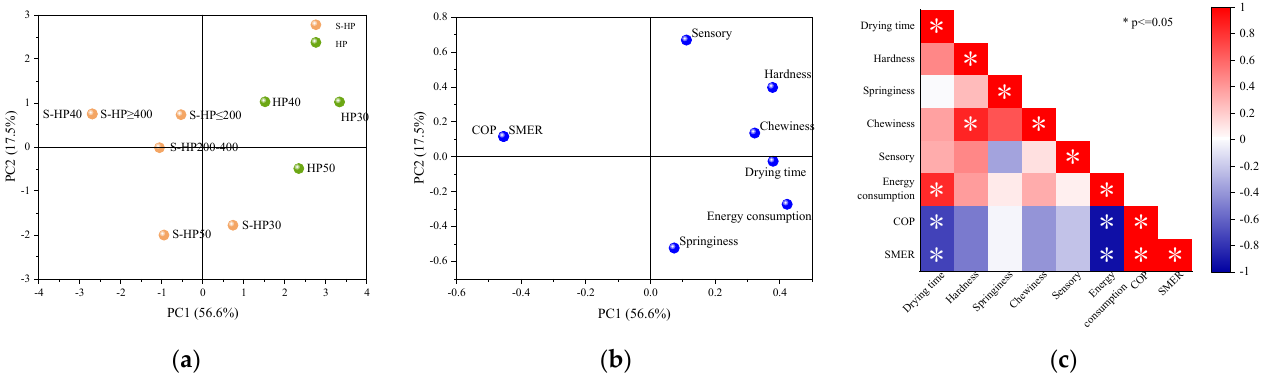
Figure 7. Score plot of principal components PC1 and PC2 ( a ) an, component plot in rotated space from the principal component analysis ( b ) and correlation plot ( c ).